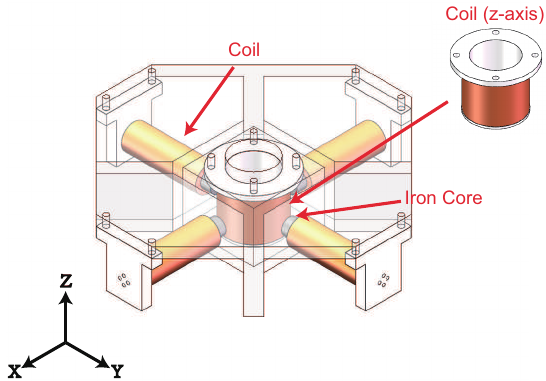
Figure 1. CAD model of the designed alternating magnetic field generation system with five electro- magnetic